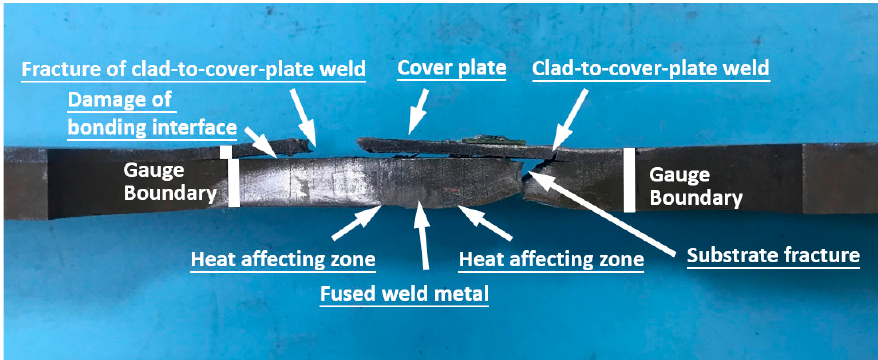
Figure 11. Failure mode of type II TC bimetallic steel butt-welded joints.